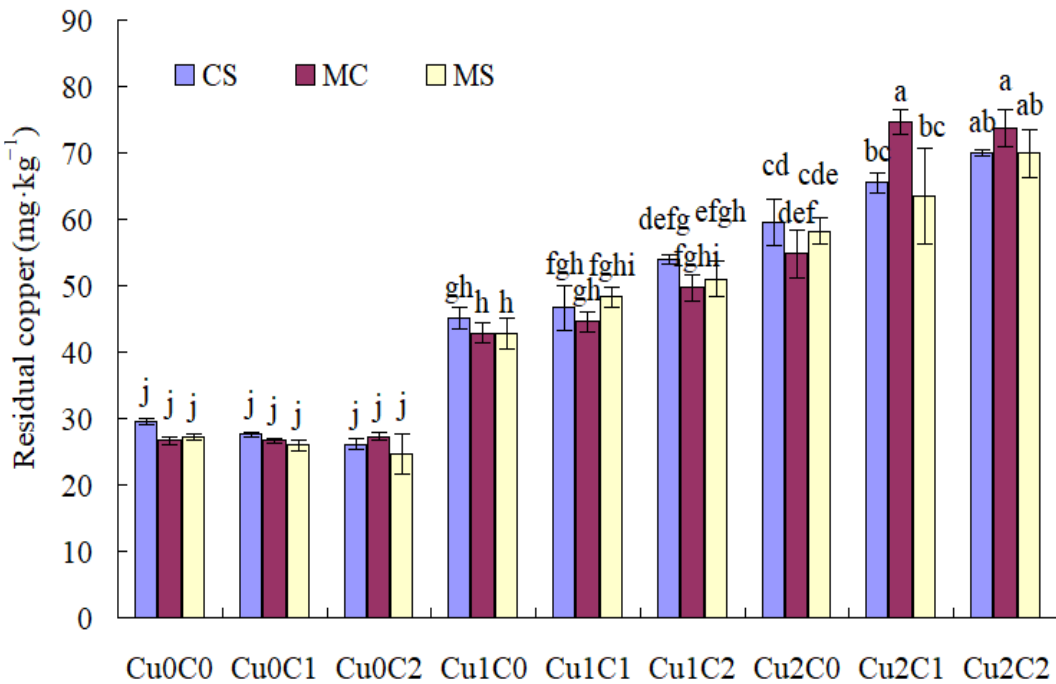
Figure 4. Soil residual copper concentration under different treatments. The different small letters above each column mean significantly different at p <0.05.